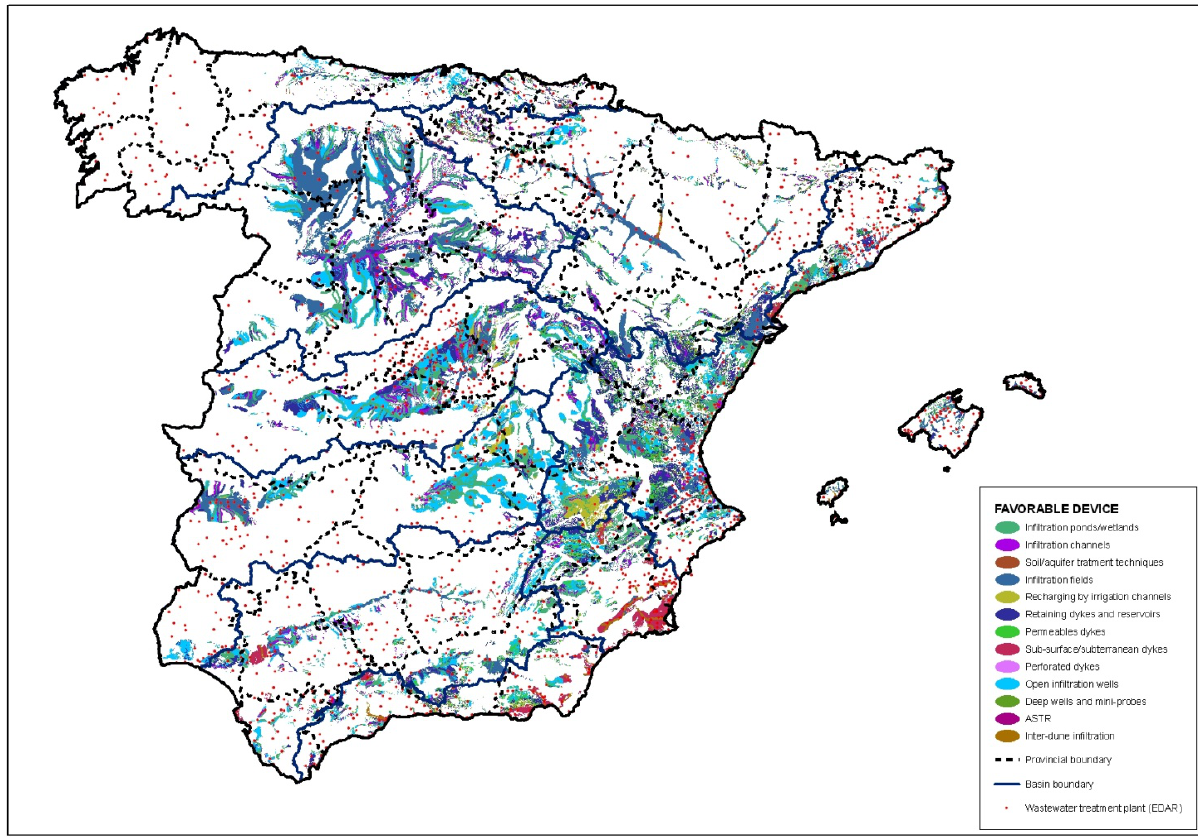
Figure 4. Map of MAR areas and the most appropriate MAR devices. The “HydroGeoportal DINA-MAR” [10] package also provides additional options for each zone.